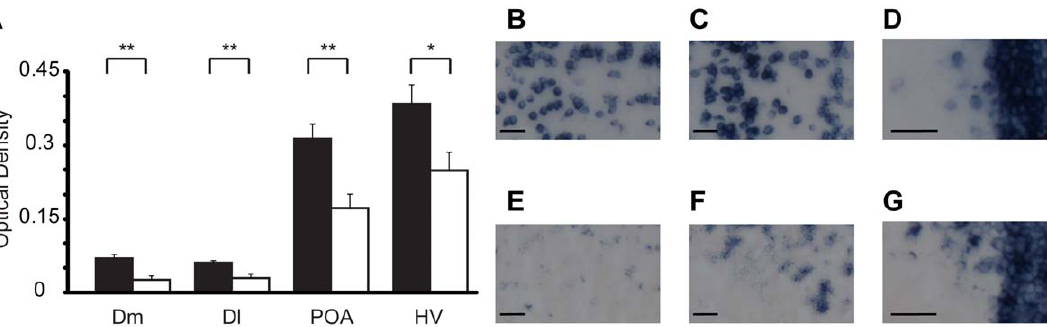
Figure 2. Neuroserpin expression in male-exposed females. (A) Significant differences in neuroserpin expression of male-exposed females (large/large, large/small, small/small) between groups of high (black) and low (white) preference score females measured in Dm, Dl, POA, and HV. Bars represent standard error. **, p , 0.01; *, p , 0.05. (B–D) are representative images of a high-preference female (preference score =0.4) for Dm, Dl, POA, respectively. (E–F) are representative images of a low-preference female (preference score = 2 0.91) for Dm, Dl, POA, respectively. Scale bar is 25